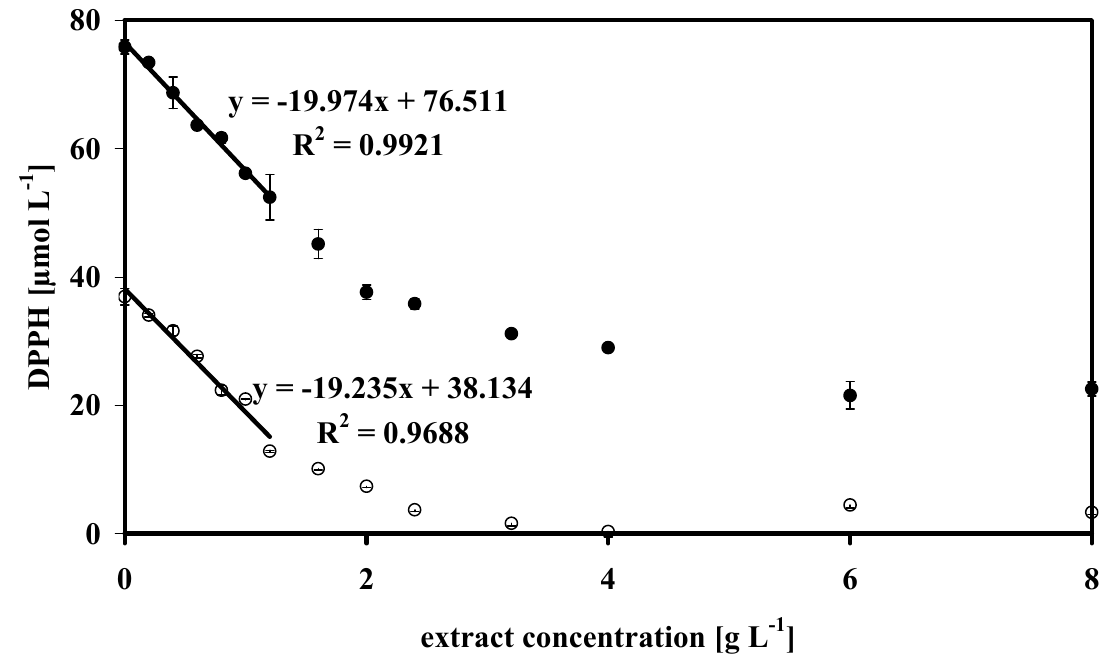
Figure 2. Absorbance decrease of the DPPH radical measured at 550 nm for Synechocystis sp. PCC6803. The reference cuvette is filled with the same extract concentration as in the measuring cuvette, but without DPPH radicals. Open circles represent the data for using the low DPPH concentration (38 µmol L -1 ). Closed circles represent the data for using the high DPPH concentration (76 µmol L -1 ). The negative algebraic signs represent the reducing of the DPPH radical by the microalgae extract. Linear regressions calculated according to Equation